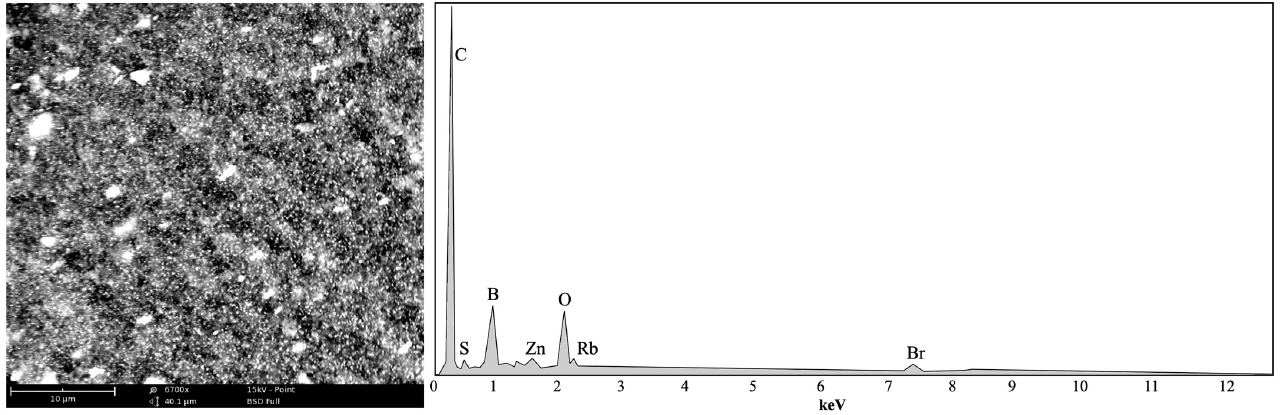
Figure 6. Cut out of map and elemental mapping.